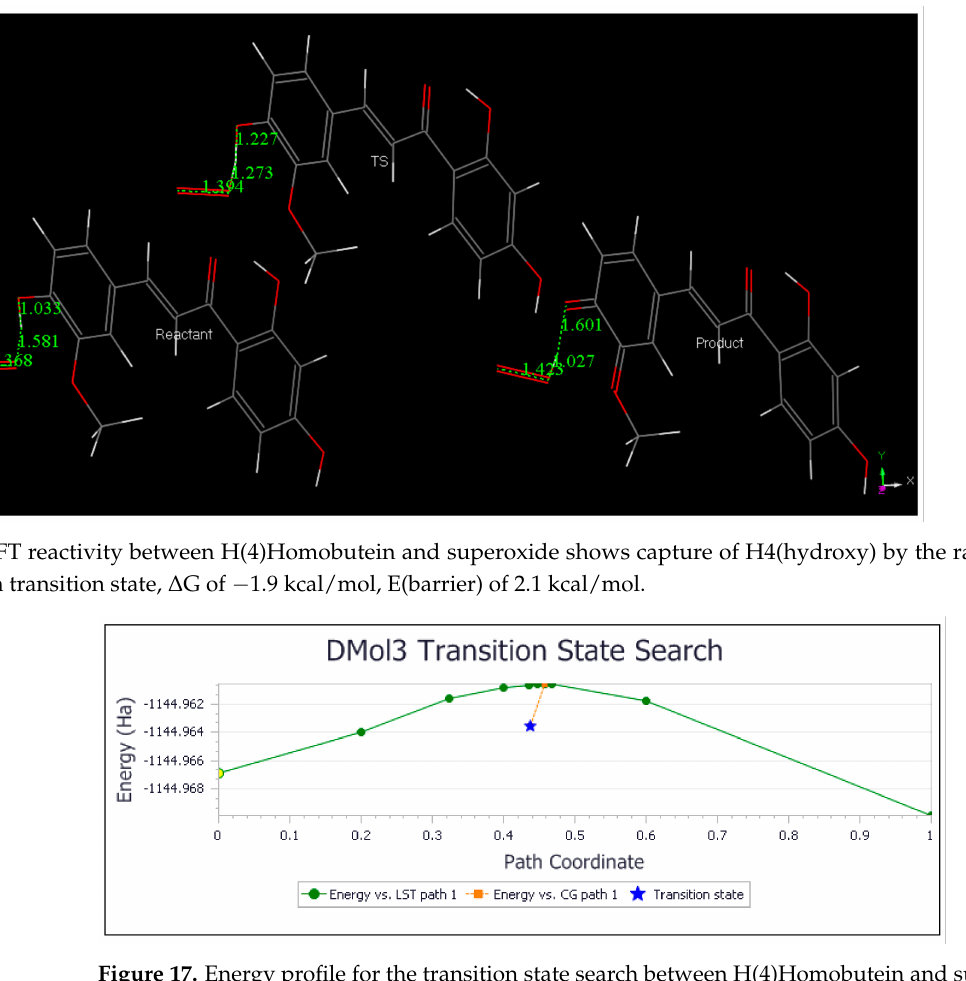
Figure 17. Energy profile for the transition state search between H(4)Homobutein and